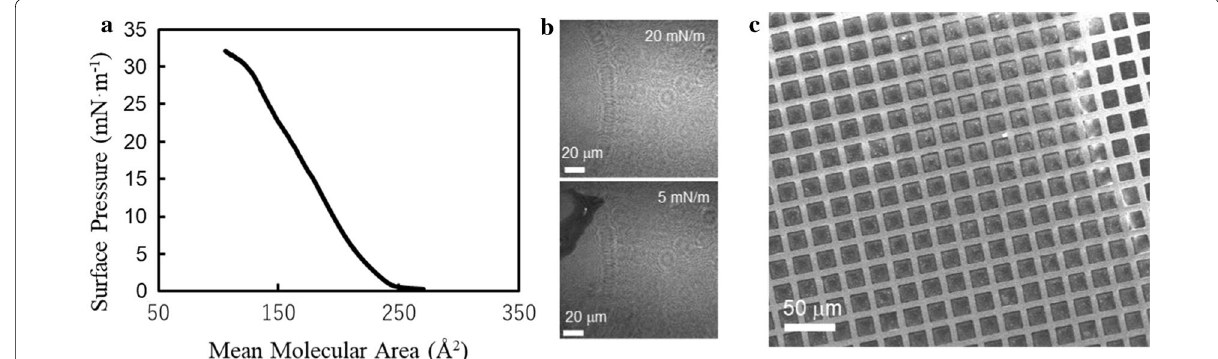
Fig. 4 Molecular design and synthesis of 2DP a surface pressure-mean molecular area isotherm, b Brewster angle microscopy images of the water surface after diffusion of 1 at surface pressure of 5 mN